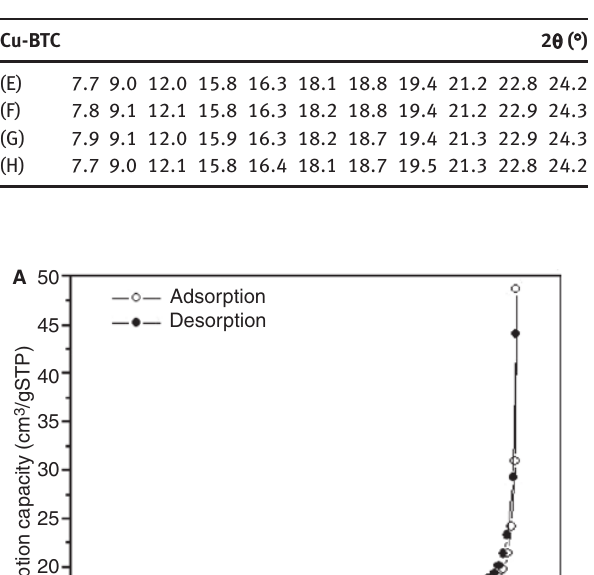
Table 7: 2 θ value of Cu-BTC, formed from Cu and benzene-1,3,5- tricarboxylic acid, hydrate with long time: 4 h (E), 13 h (F), 18 h (G) and 24 h (H).